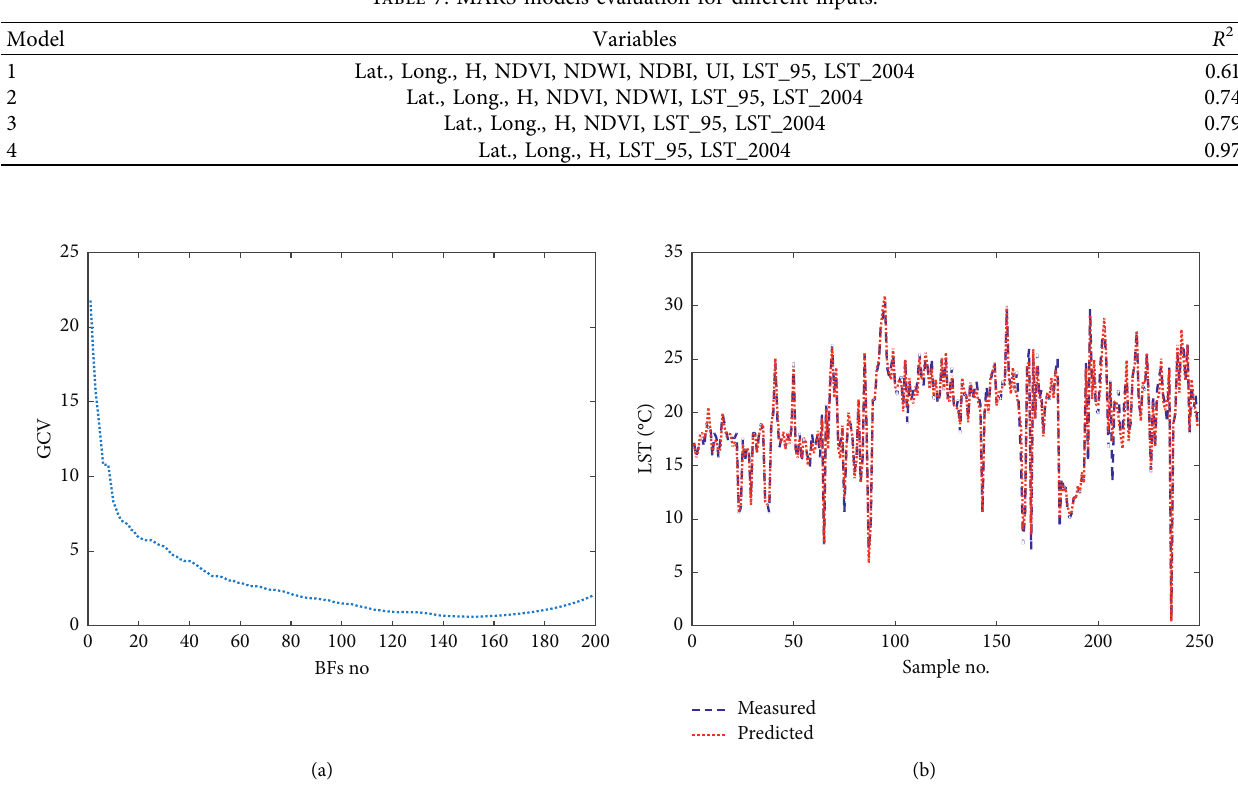
Figure 8: MARS model performance. (a) GCM; (b) measurement and prediction of LST-2010.